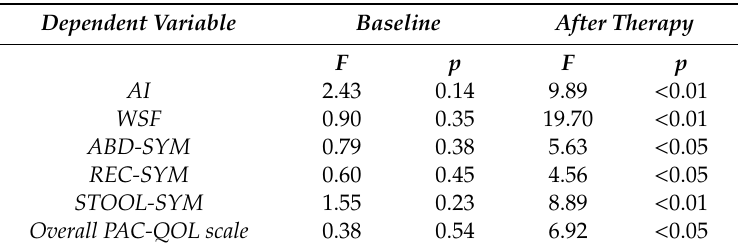
Table 2. Analysis of the di ff erences between EMG-biofeedback group and control group in the baseline and after therapy for each dependent variable.